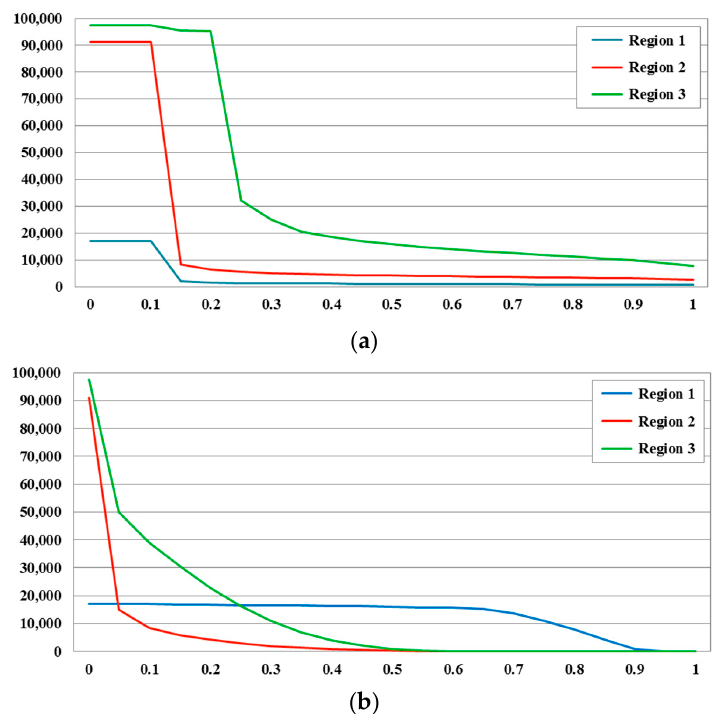
Figure 15. ( a ) The urban pixel count distributions of PUL in three regions; and ( b ) the urban pixel count distributions of LISI in three regions. The x -axis is the value of the threshold; and the y -axis is the pixel count of the urban area.